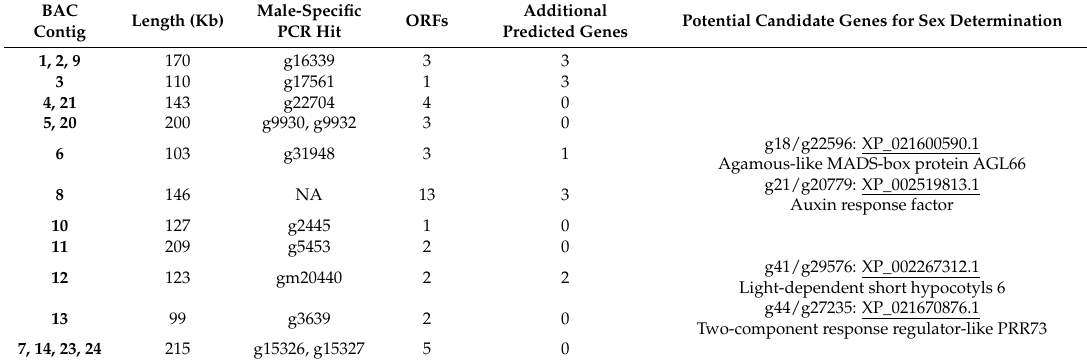
PCR: Polymerase chain reaction; ORF: open reading frame; NA: not